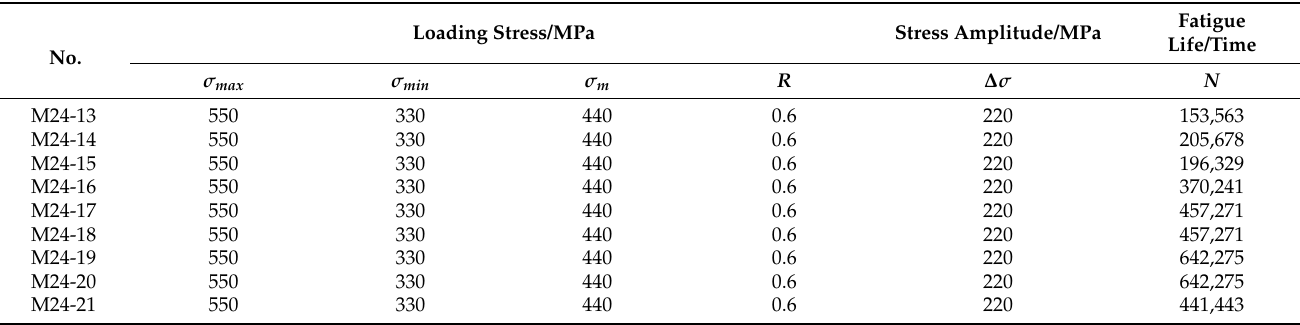
Table 7. Constant amplitude fatigue test results of M24 torsional shear-type high-strength bolt with pretension ( σ max = 550 MP).